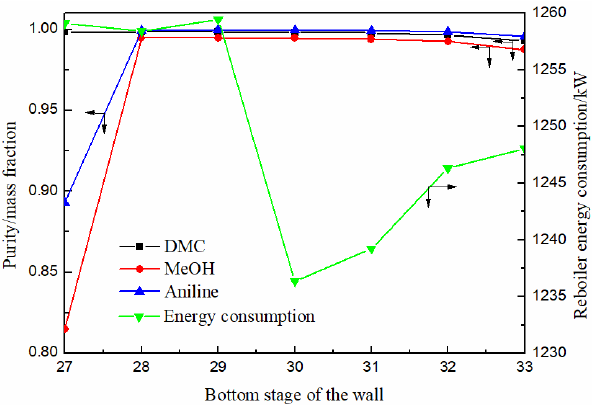
Figure 6. Effect of bottom stage of the partition on product purity and heat duty of reboiler.